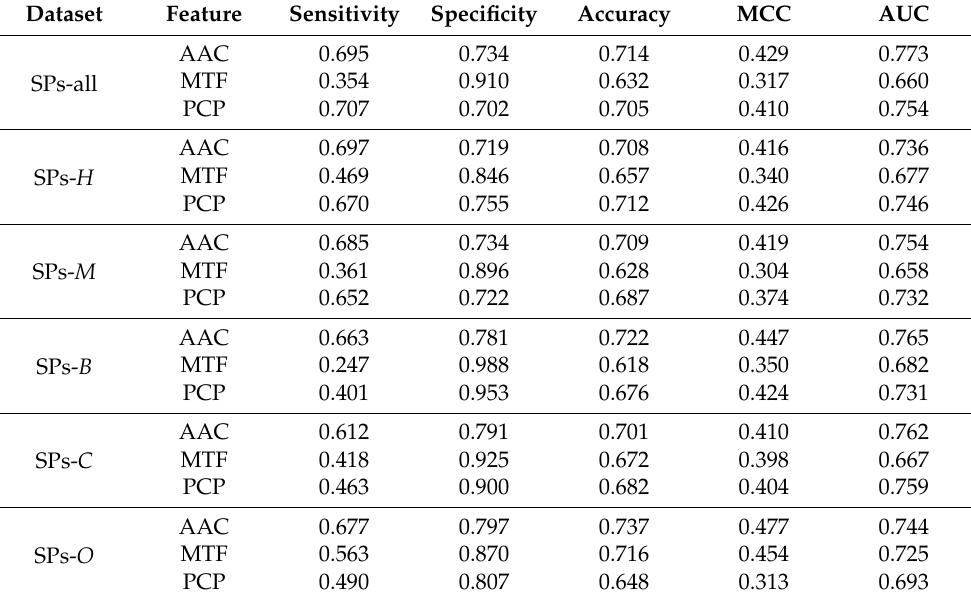
Table 2. The prediction performance of different features on six training datasets over five-fold cross-validation.